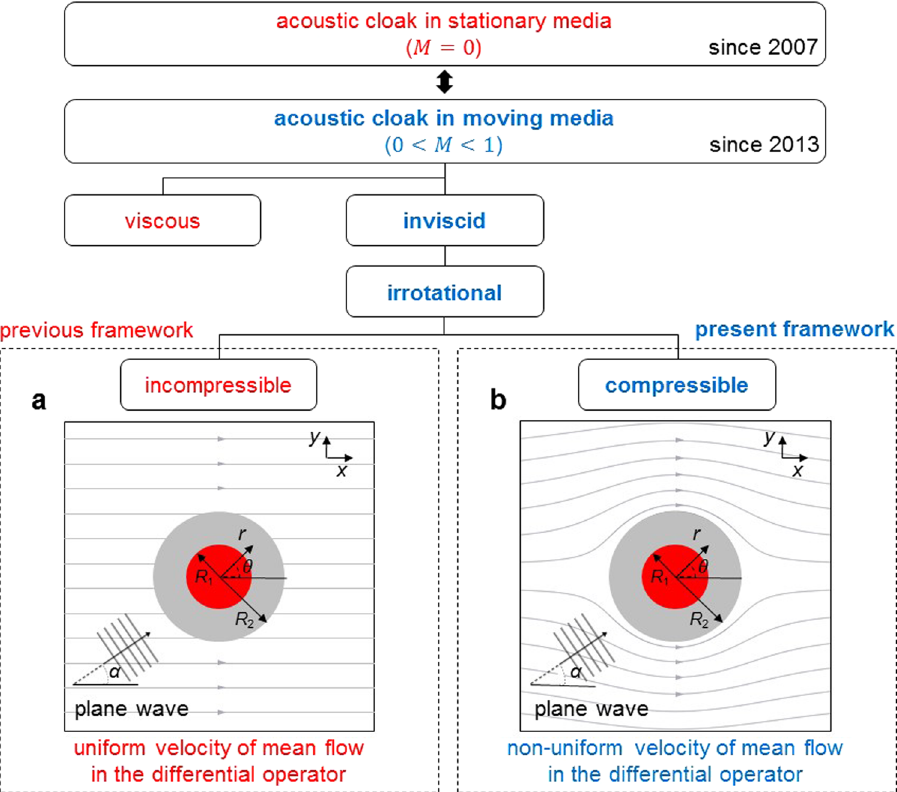
Figure 1. Schematic of acoustic cloak research in stationary and moving media. Early works on acoustic cloak have been done in the absence of flow for a decade. Recently, only a few researchers studied acoustic cloak in the presence of flow. Since the complete study on flow effect is extremely complicated, the flow was assumed to be inviscid and steady. Two boxes with dotted lines show the comparison of the previous and present theoretical frameworks in the presence of flow: ( a ) In the previous work 7 , the flow was assumed to be incompressible and the differential wave operator contained the uniform velocity. ( b ) In the present work, the flow is compressible so that the sound is refracted due to density inhomogeneity and spatially varying speed of sound, and the differential wave operator contains the non-uniform velocity around the acoustic